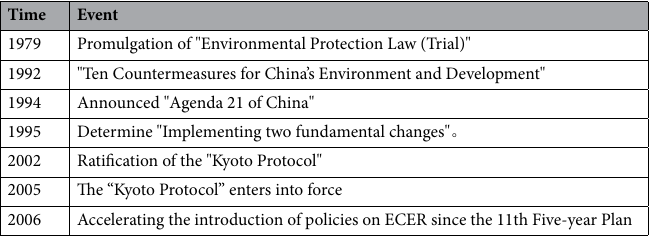
Table 1. Evolution of China’s ECER policies before 2006. The information collected by